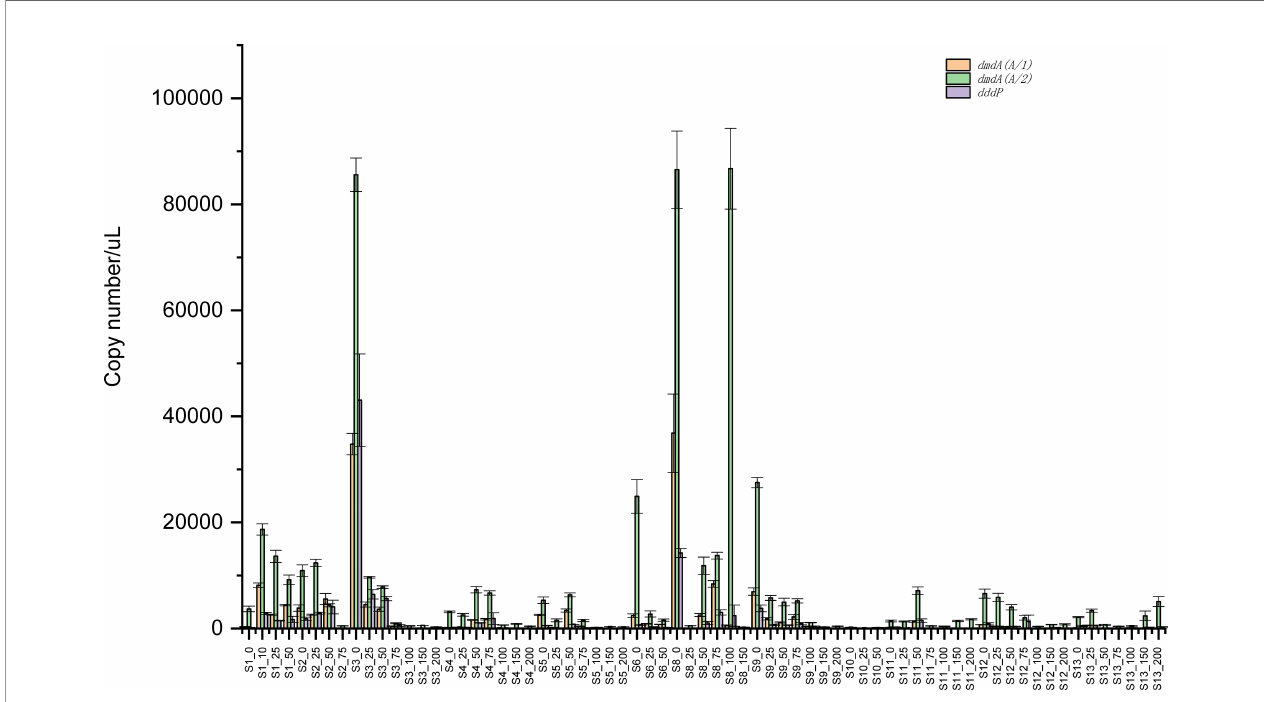
FIGURE 2 | Abundance of dmdA and dddP in the SCS from surface water to 200 m depth based on quantitative